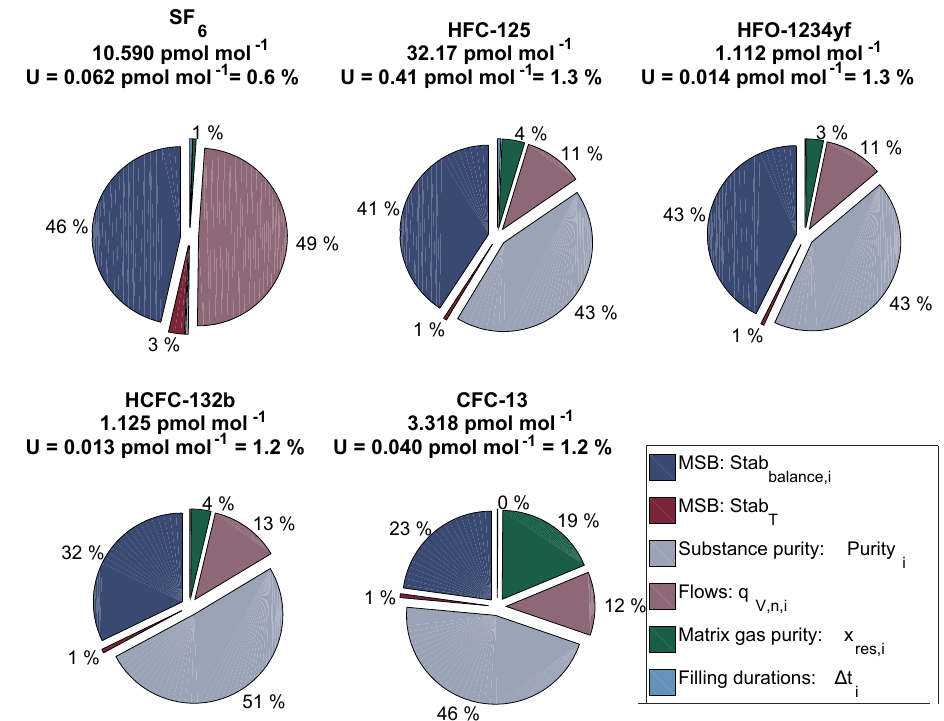
Figure 3. Uncertainty budget of the preparation for cylinder MP-001. The pie charts depict the most important sources of uncertainties, in percent, for each substance (see also Sect. 2.5.1). U is the relative expanded uncertainty of the preparation ( k = 2). All input values used to calculate the budget for SF 6 in MP-001 are detailed in Table